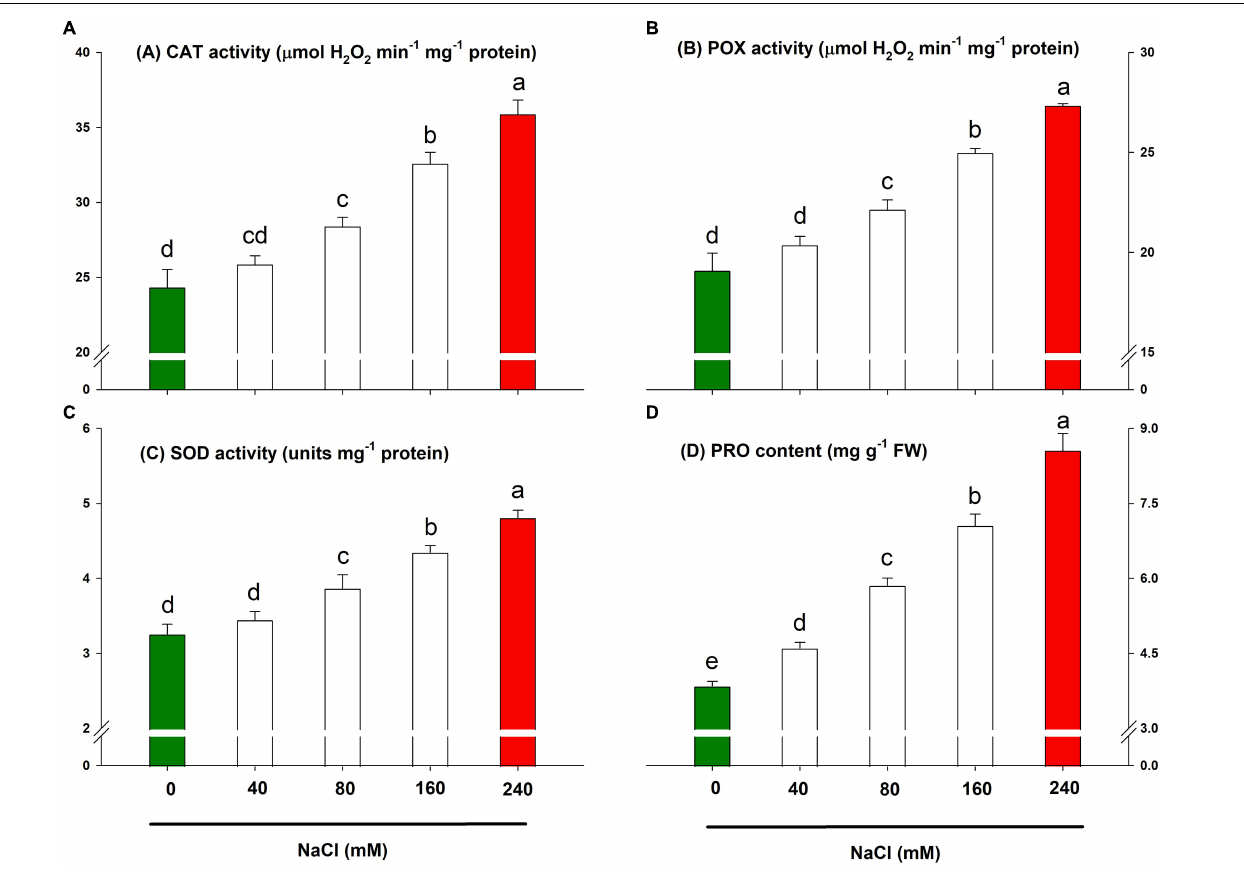
FIGURE 7 | Lemongrass defence system and salinity stress. The activities of enzymatic antioxidants such as catalase (A) , peroxidase (B) , and superoxide dismutase (C) , and the content of osmolyte proline (D) are depicted here. Each bar represents mean ± SE ( n = 3). Means followed by the same letter(s) do not differ by LSD test at 5% probability level ( α = 0.05). The colors are just visual ques for readers to quickly distinguish between control and most stressed treatment.